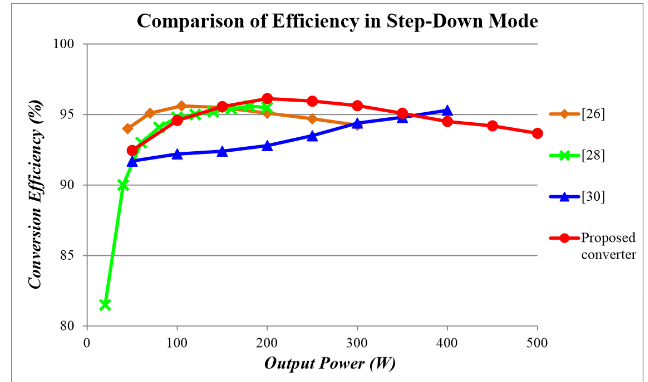
Figure 22. Comparison of the energy conversion efficiency of the proposed converter in the step- down mode with those of the converters in [26,28,30].